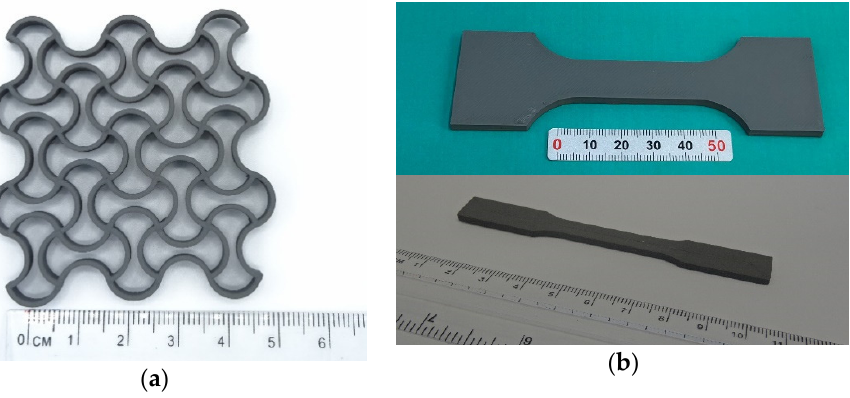
Figure 4. ( a ) Green part auxetic structure, ( b ) Tension rods.